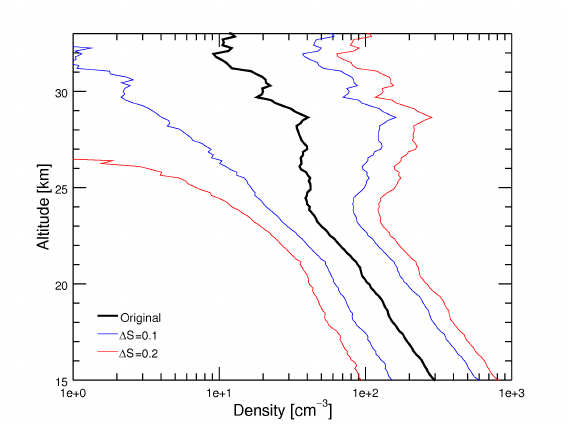
Figure 13. Aerosol number density profile ( N A ) for March 2013 inferred with an assumed distribution width of S = 1.5 (Original). Blue and red lines indicate the total error ranges of the two assumed deviations ( ∆ S ) of the distribution